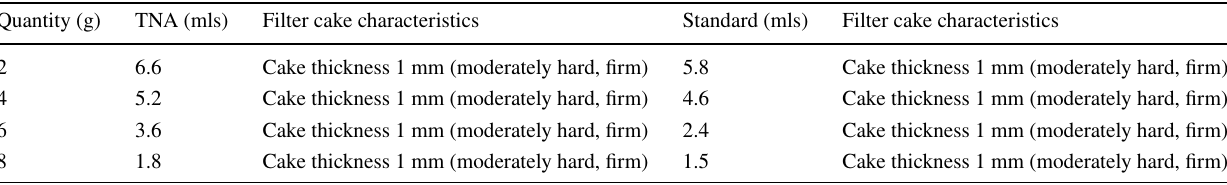
Table 5 Filter cake thickness and filtrate volume compared with standard Quantity (g) TNA (mls) Filter cake characteristics Standard (mls) Filter cake